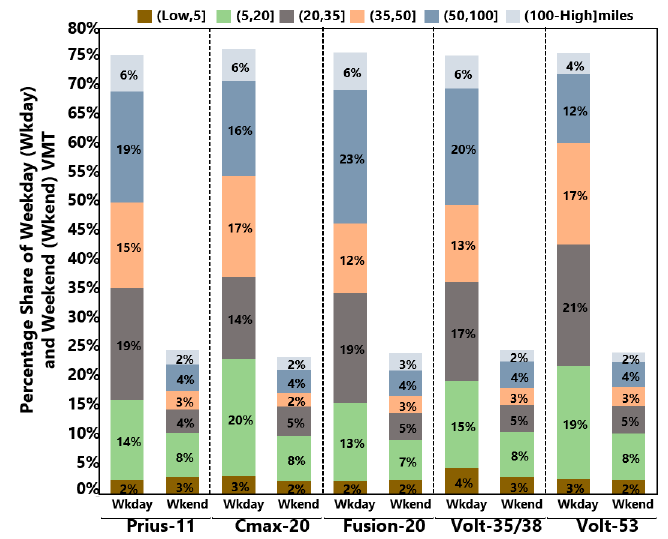
Figure 7. Percentage share of total VMT by distance traveled on weekdays and weekends.